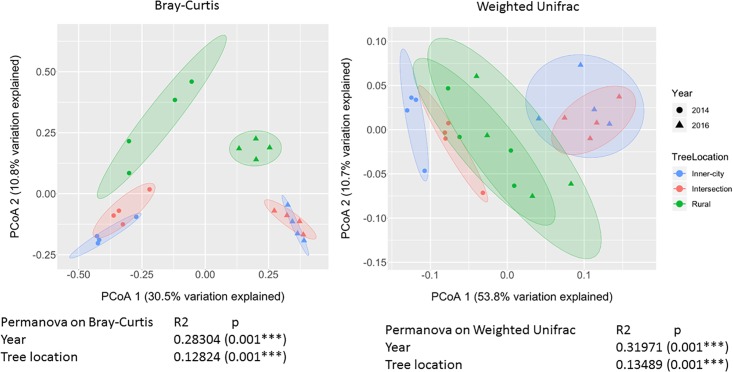
PCoA plot of Bray-Curtis dissimilarity values and Weighted Unifrac between epiphytic bacterial communities on Platanus × hispanica leaves. Circles = 2014, triangles = 2016. Blue = Inner-city, red = Intersection, and green = Rural. Each normal data ellipse is drawn at a level of 0.80.